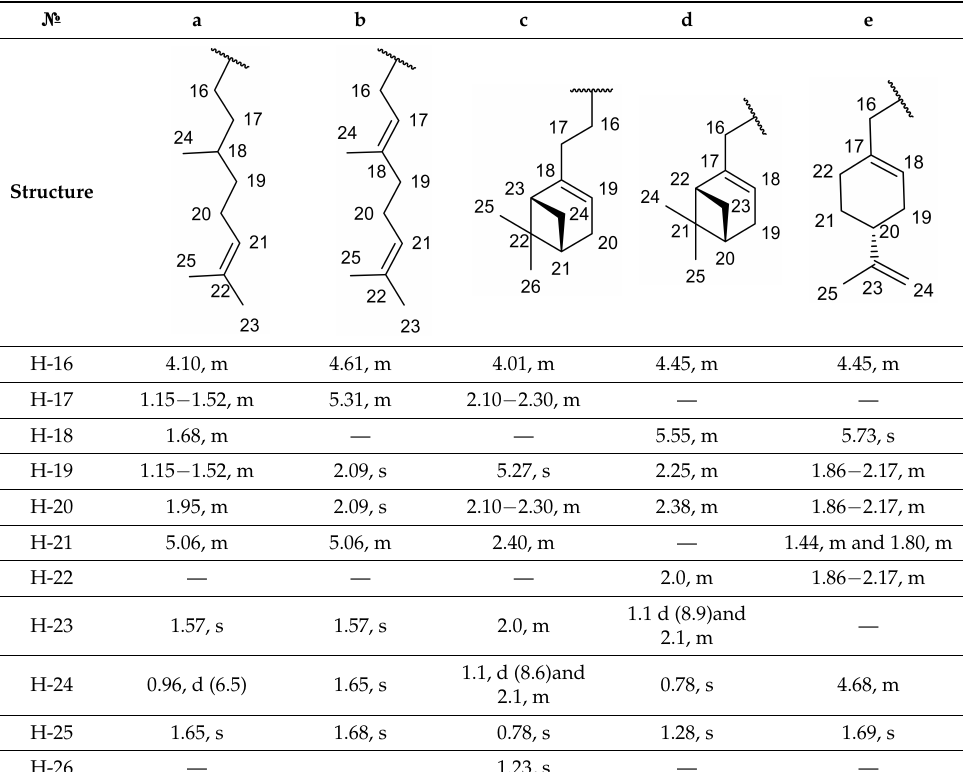
Table 3. NMR 1 H spectra of 13a - e